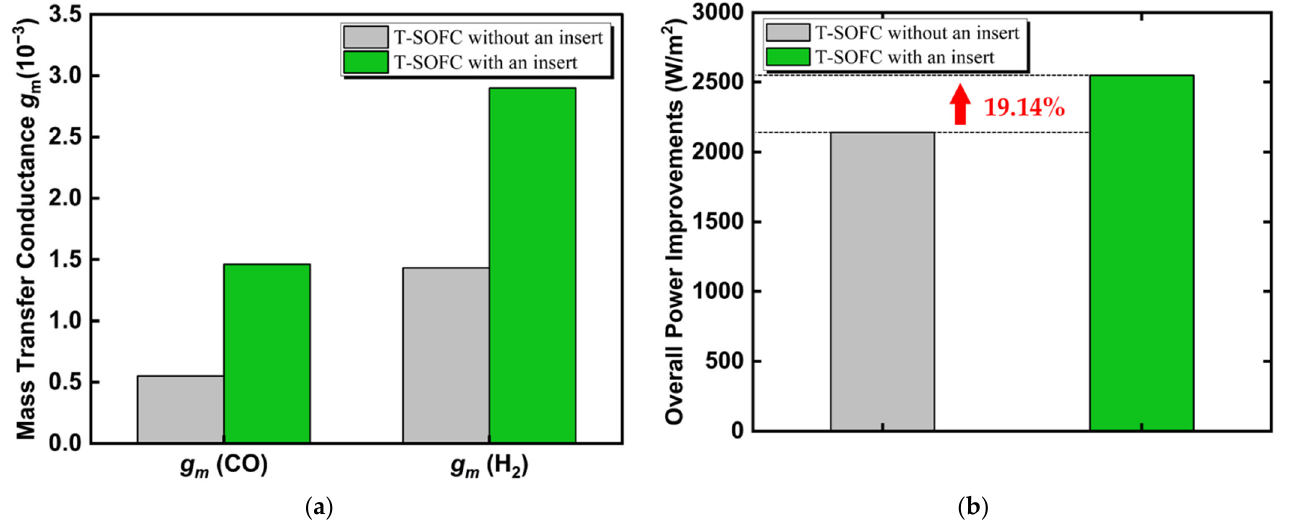
Figure 9. Comparison of ( a ) the mass transfer conductance and ( b ) the power densities in tubular SOFCs with and without inserts.